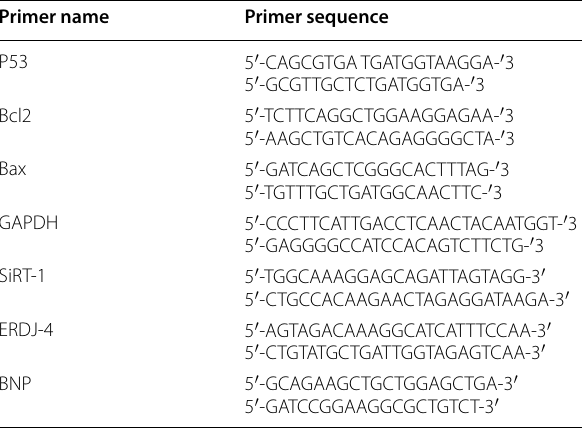
Table 1 Primers sequence designed for RT-PCR gene expression